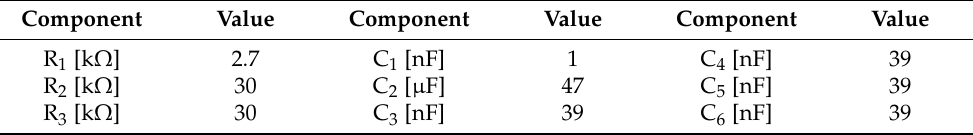
Table 2. Passive components in the transmitter system—block A.